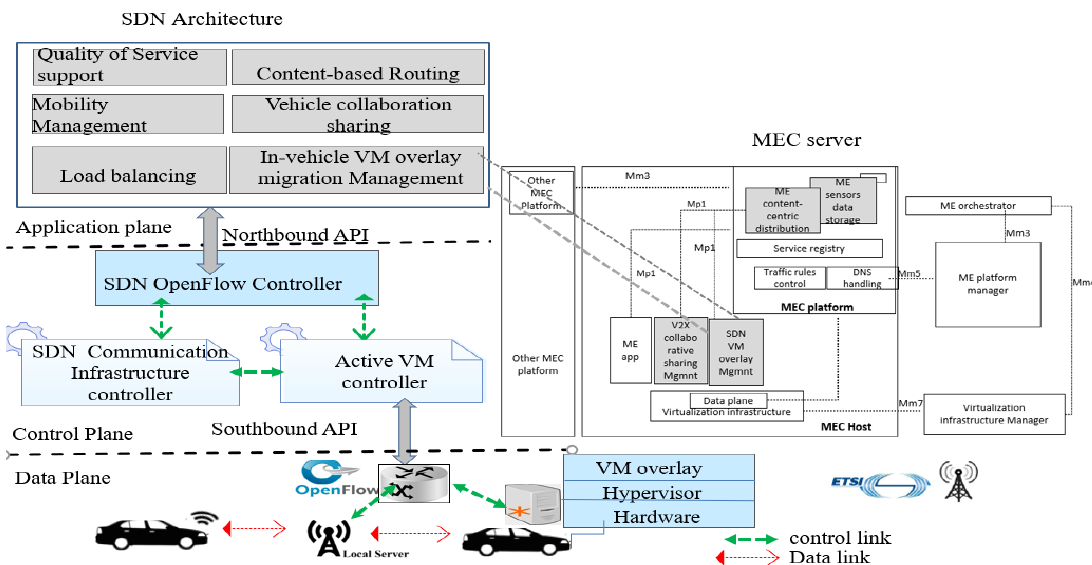
Figure 6. Multi-access edge cloud-enabled SDN (left) and MEC server (right) for VM